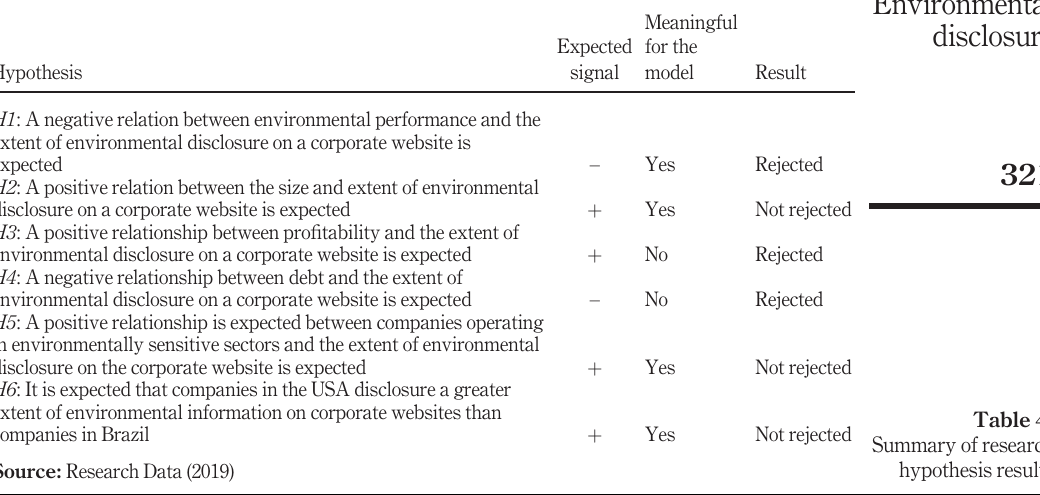
Table 4. Summary of